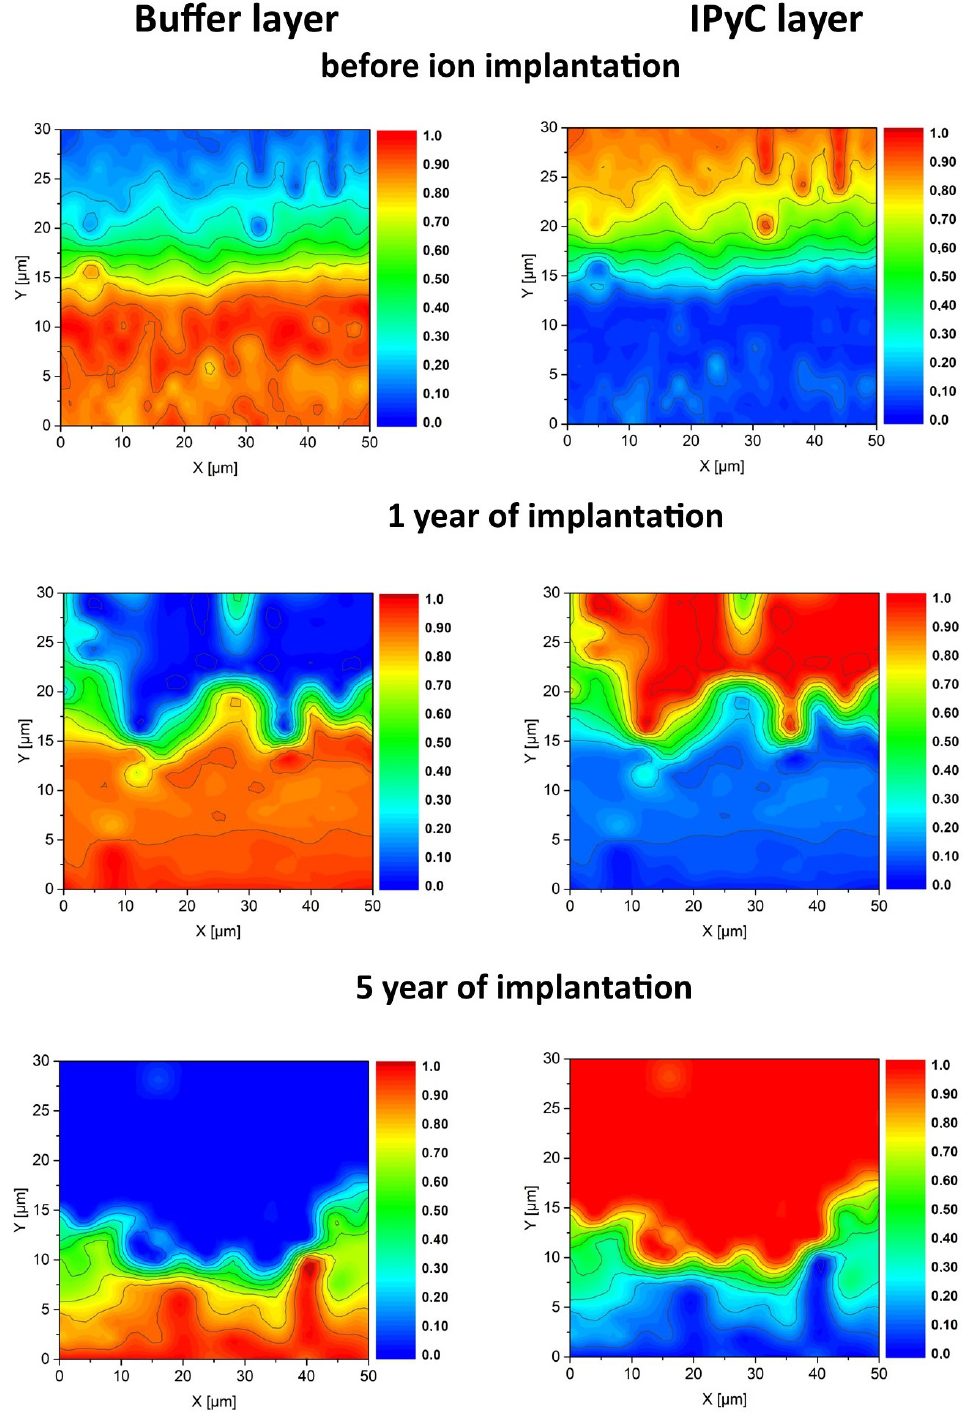
Figure 4. Raman maps of the averaged S-3 p-TRISO particles.